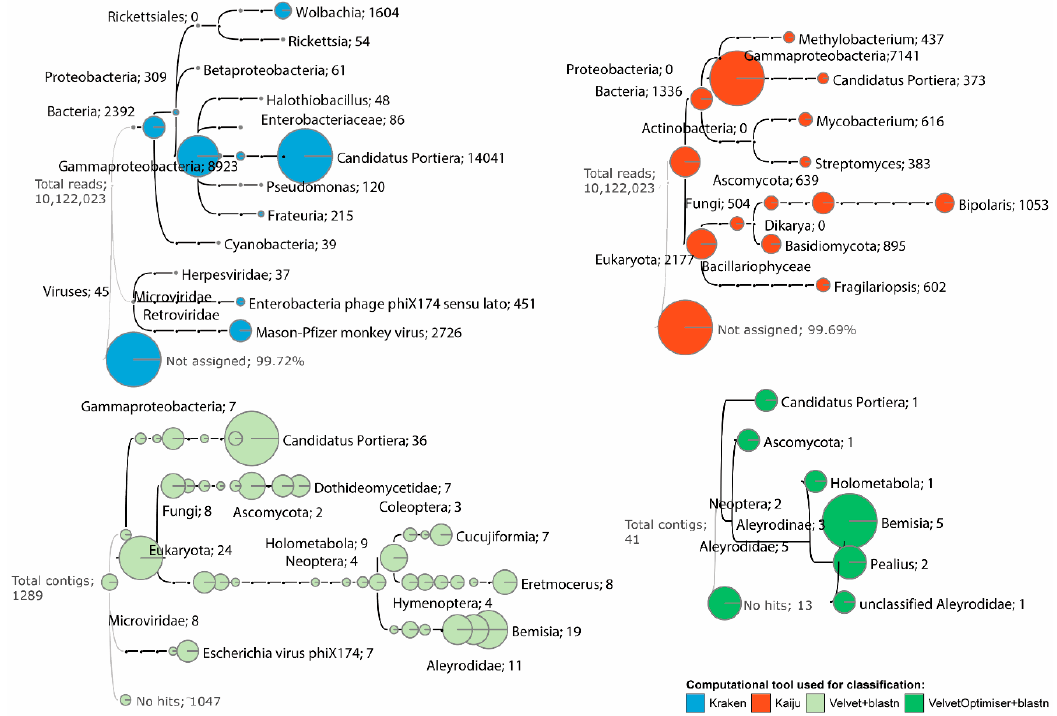
Figure 2. Dendrograms of the microbiome of Aleurocanthus spiniferus infesting Ailanthus altissima based on the results obtained using four different tools for taxonomic assignment of small RNA reads. The size of the circles is proportional to the number of reads or contigs placed in the taxon. Small RNA reads were subjected to Kraken and Kaiju or were assembled into contigs using Velvet or VelvetOptimiser prior to search sequence similarities against the BLAST nr database.